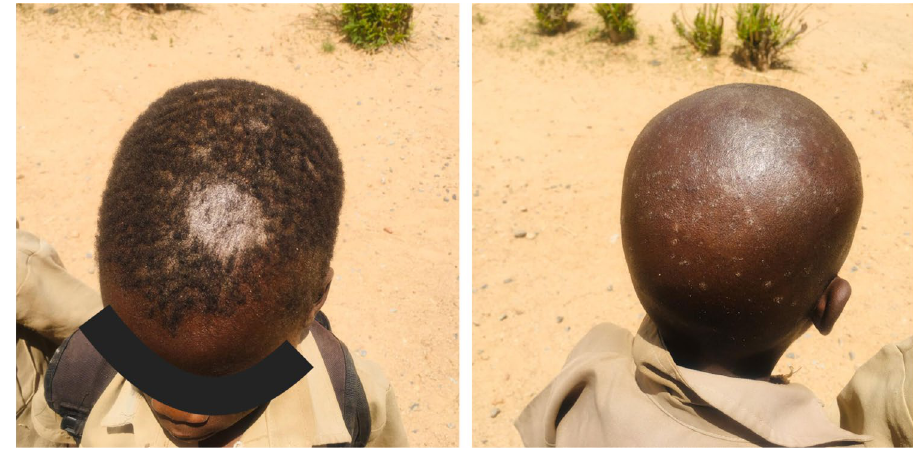
Figure 2. Tinea capitis infection in two young boys from rural